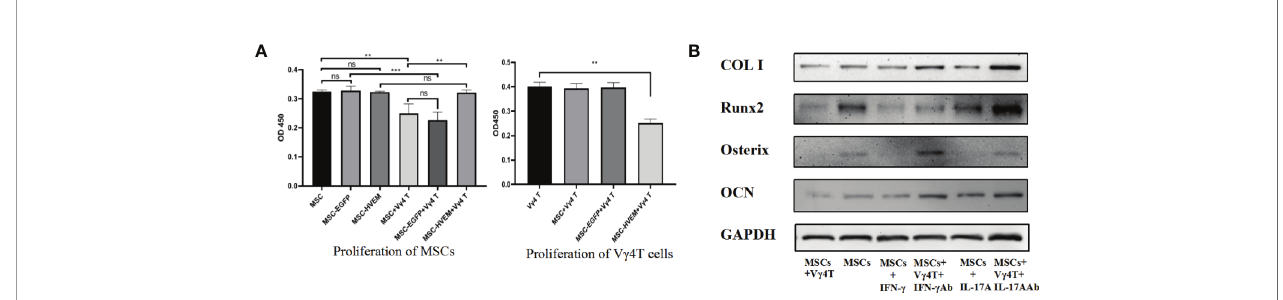
FIGURE 5 | The effect of V g 4T cells on MSCs proliferation and osteogenic differentiation. (A) The proliferation of cell was measured by using CCK-8 assay on 3 rd day. Absorbance values at 450 nm for each group are shown when MSCs or MSCs-HVEM co-culture with or not with V g 4T cells. Data are reported as means ± SD. * 0.01 ≤ P ≤ 0.05, ** P ≤ 0.01, *** P ≤ 0.001 (One Way ANOVA). (B) The Expression of markers of osteogenesis such as COL I, Runx2, Osterix, and OCN by MSCs with V g 4T cells (the ratio is 1:4) treated with IFN- g , IFN- g antibody (IFN- g Ab) , IL-17A, IL-17A antibody (IL-17A Ab) are shown. Error bars represent mean ± SD. One-way ANOVA test was used to calculated P value (**P < 0.01, ***P < 0.001, ns P